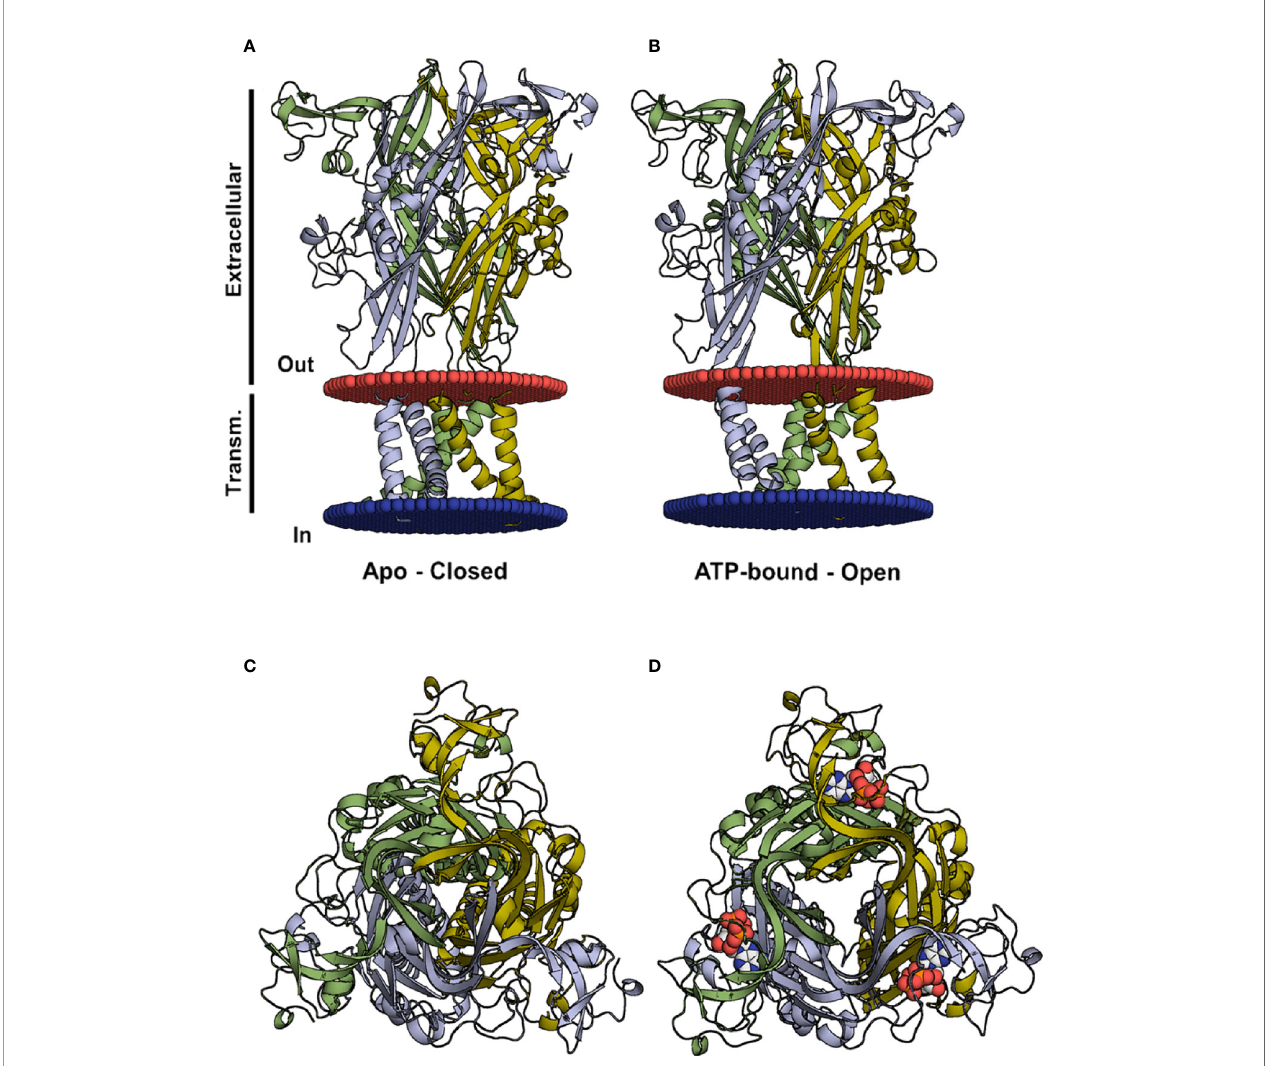
FIGURE 1 | Three-dimensional structures of the closed and open (ATP-bound) P2X4 states. (A , B) Crystal structure of the zfP2X4 (PDB code 4DW0) in different views, apo and open, with the transmembrane helices colored according to the subunit colors in blue, yellow, and green. ATP molecules are displayed as a van der Waals representation. (C) The same structure as in (A) , viewed from the top along the axis of the central channel. (D) The same structure as in (B) , seen from the top along the axis of the central channel, with ATP bound to the pharmacophore